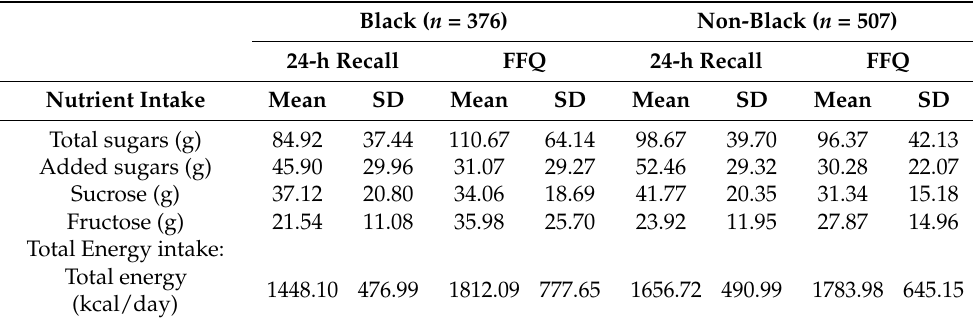
Table 3. Means and standard deviation for non-energy adjusted total sugars, added sugars, fructose, and sucrose intake per day assessed by FFQ and multiple 24-h recall specified by race ( N = 883).